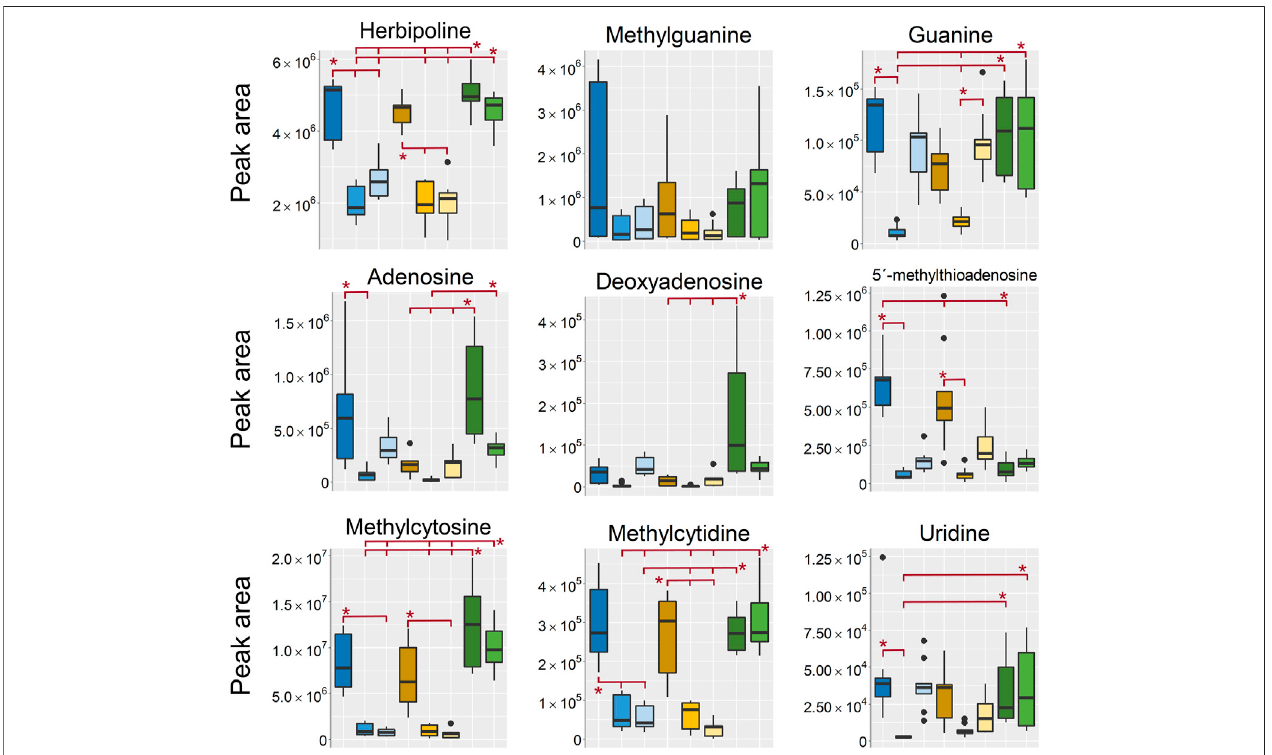
FIGURE 7 | Boxplots of peak areas ( y -axis) of nucleotides, nucleosides and nucleobases found as differentiating between the sample treatments in the aqueous extracts. All boxplots in the fi gure was based on data from the analysis in positive ionization mode, except for uridine which, was detected in negative ionization mode. EtOHextr.1(darkblue ),EtOHextr.2(blue ),EtOHsp.(lightblue ),MeOHextr.1(darkorange ),MeOHextr.2(yellow ),MeOHsp.(lightyellow ),frozen(dark green ), and fl ash frozen (green ). Outliers are denoted as dots in the plots. Statistical signi fi cance ( p < 0.05) is marked by * in the respective box-plots, all p -values from the Kruskal Wallis and Nemenyi post-hoc testing can be found in supplementary data, Supplementary Table S10 .